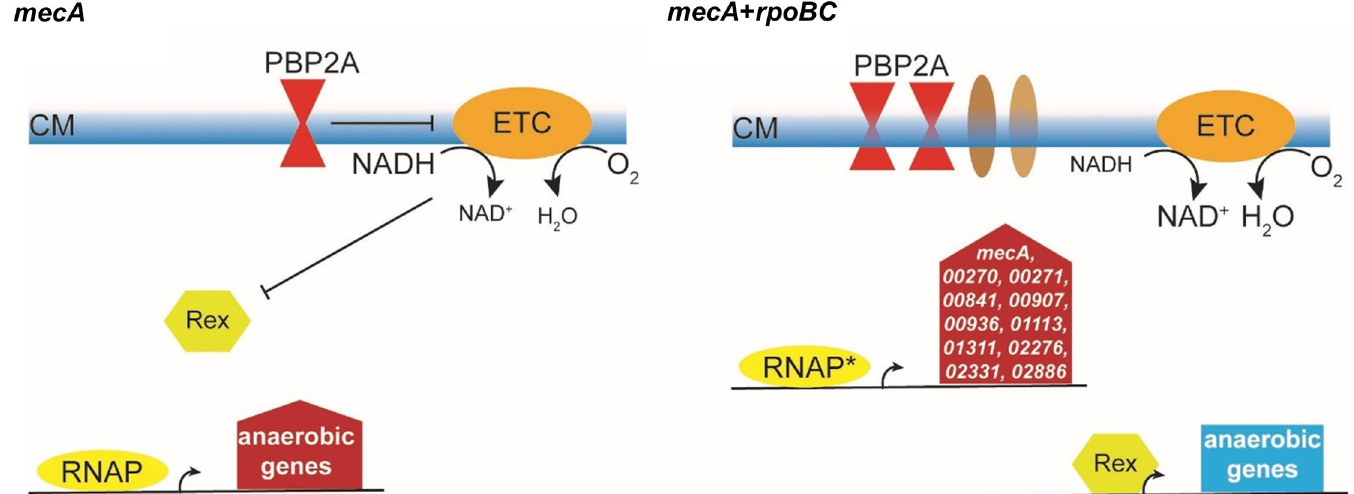
Fig 10. Model of adaptations associated with the development of high-level β -lactam resistance. Strain lysA ::p mecA (SJF4996) (left) expresses chromosomal mecA , with PBP2A protein (red hour glass) incorporated into the cell envelope. This perturbs cell membrane (CM) function ( ? ), resulting in decreased flux through the aerobic electron transport chain (ETC). The resulting increased NADH:NAD + ratio (indicated by font size) inhibits DNA-binding by the transcription factor Rex (green hexagon) and the anaerobic respiratory and fermentative genes (anaerobic genes) are transcribed (red filled arrow) by the native RNA polymerase (RNAP). This results in a low-level resistance phenotype. Evolved strains have missense mutations in the rpoB/C (RNAP � ) that permit enhanced expression of 11 genes, including mecA and two genes associated with the Type VII secretion system ( SAHOUHSC_00270 and 00271 ). Incorporation of some of the gene products (e.g. SAHOUHSC_00270 and 00271 ; brown ellipses) into the cell membrane allows integration of PBP2A activity into ‘normal’ membrane function. This results in lower NADH:NAD + ratios, permitting Rex to repress expression of anaerobic genes (blue rectangle), the restoration of aerobic respiratory growth and high level β -lactam resistance.